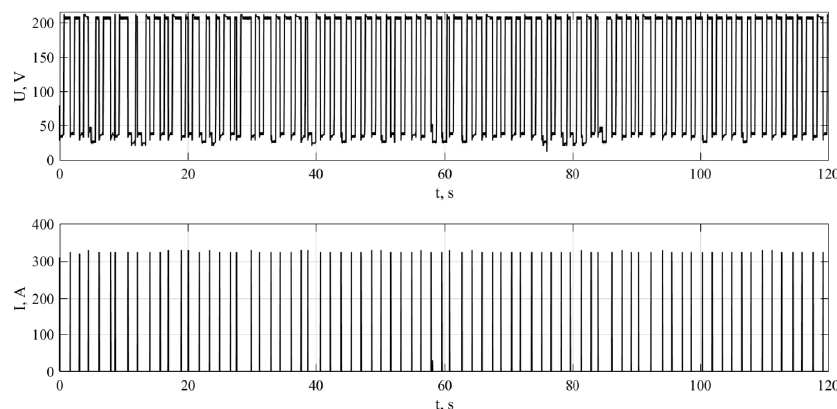
Figure 6. Oscillogram of impulses at a voltage of 100 V.